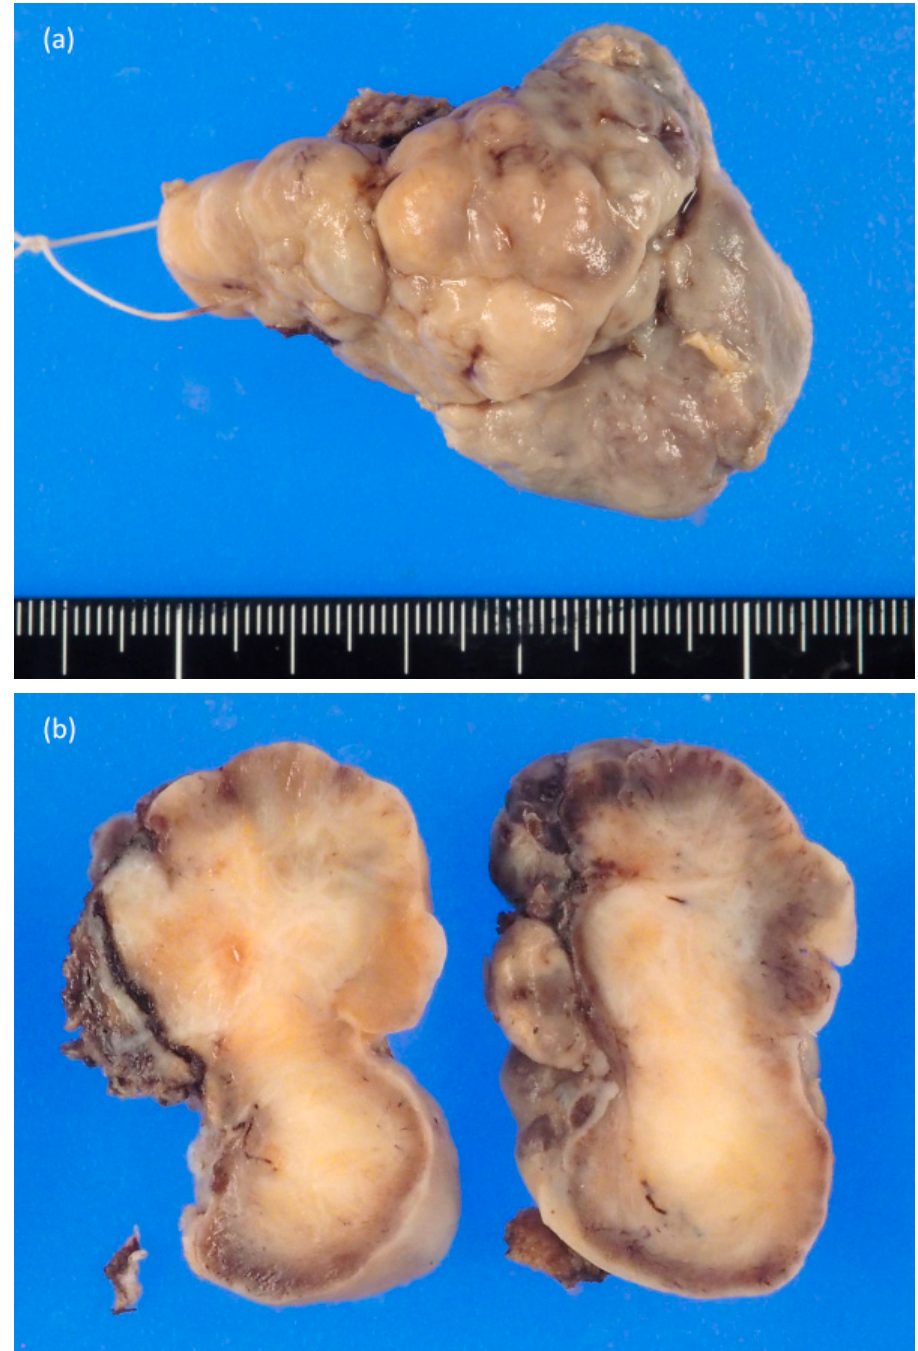
Figure 3. Gross findings of the resected material. ( a ) The tumor was raised mass with a bumpy surface. ( b ) The cut surface of the tumor was solid, white to yellowish-brown, and brown near the surface.